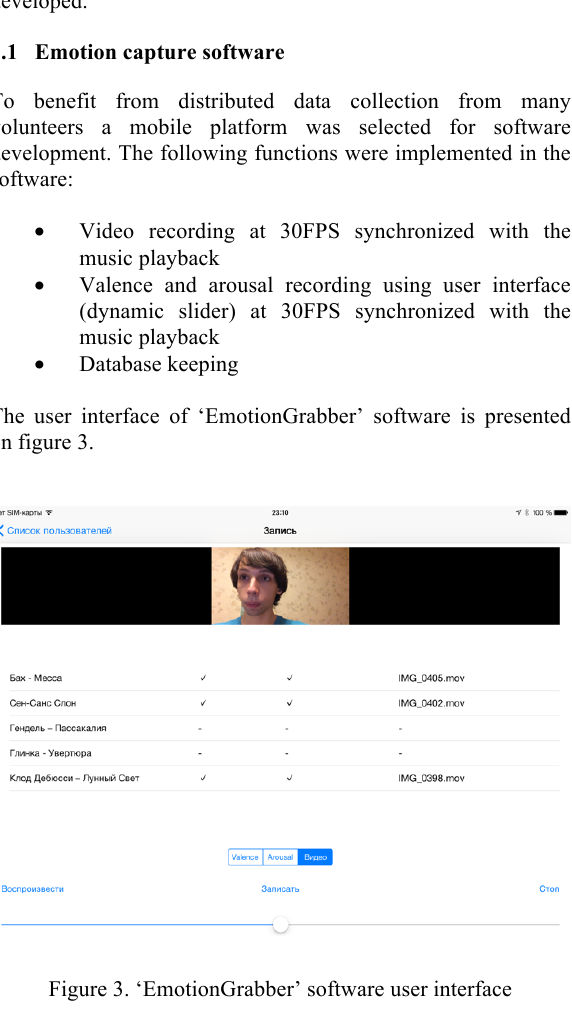
Table 1. Facial animation parameters and corresponding facial feature points used for representations of facial expression